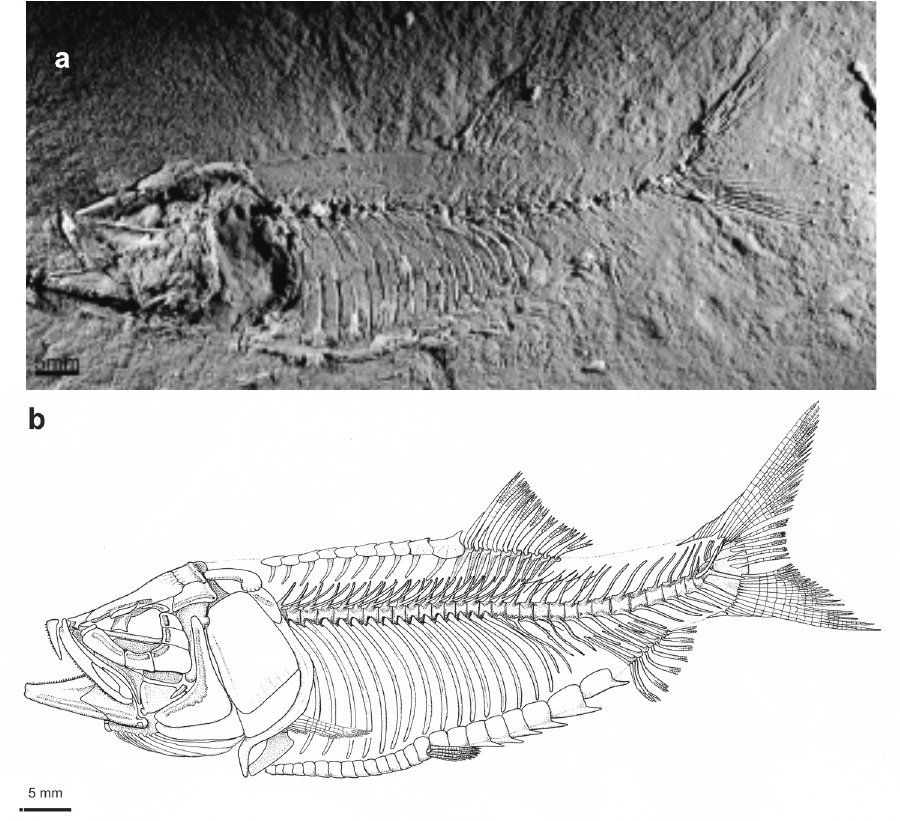
Figure 1 . † Scutatuspinosus itapagipensis Santos and Corrêa 1985: ( a ) photograph of the holotype (DGM 1164-P); ( b ) restoration of skeleton mainly based on DGM